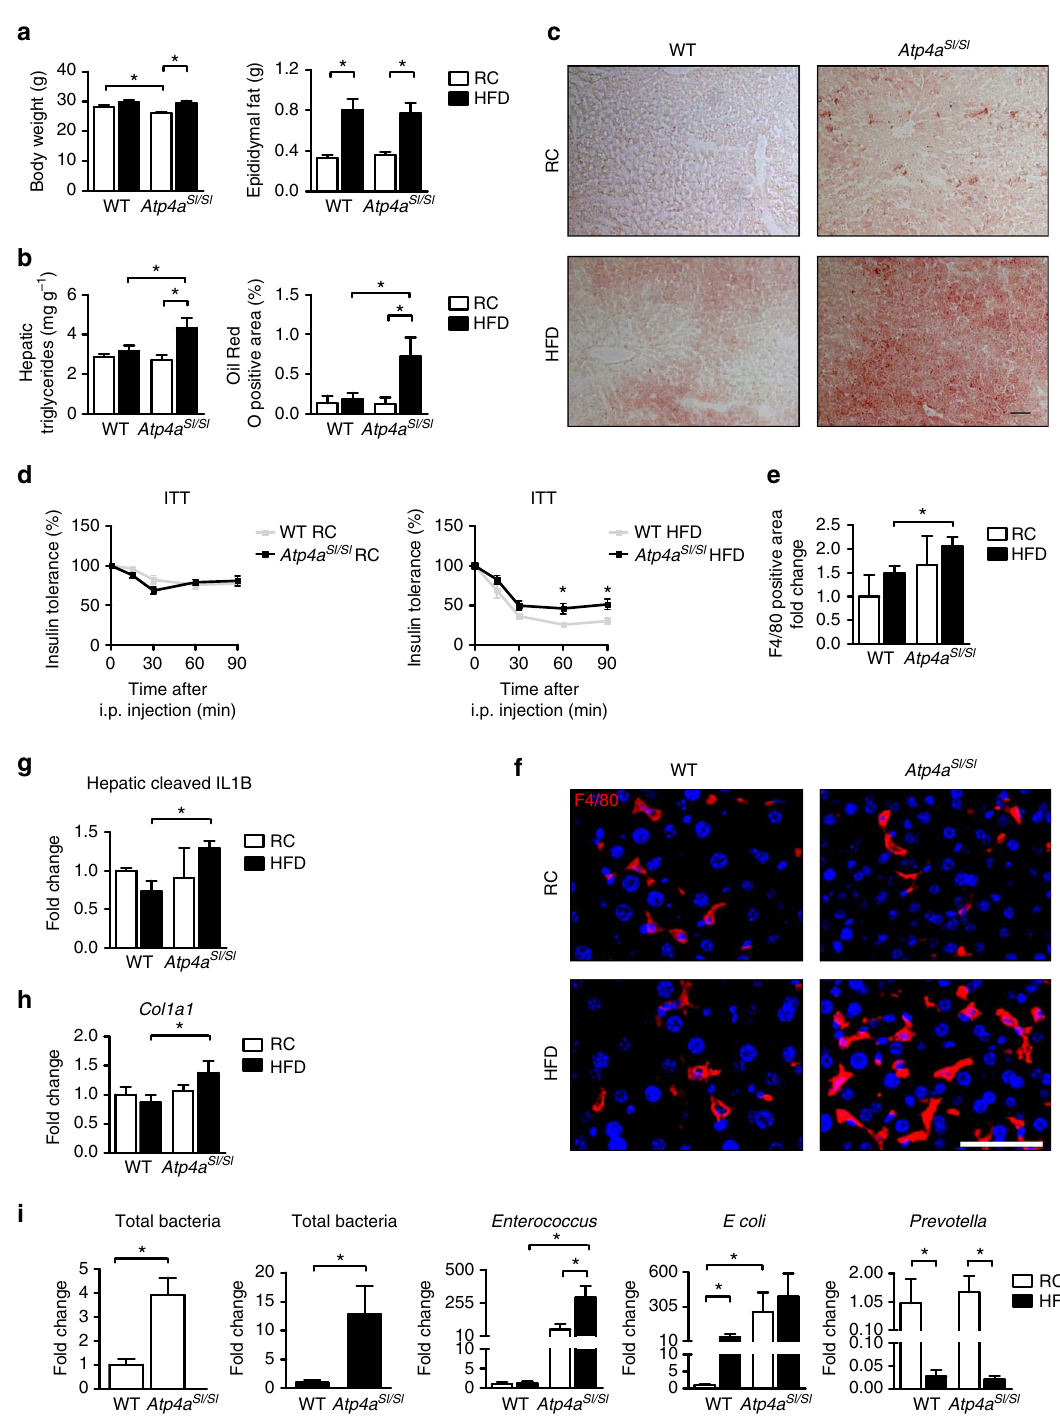
Fig. 2 NAFLD is increased in Atp4a Sl/Sl mice. WT mice and their Atp4a Sl/Sl littermates were fed a regular chow (RC) diet ( n = 5 – 8; 2 – 3 replicates) or a HFD ( n = 6 – 15; 3 – 6 replicates) for 9 weeks. a Body weight and weight of white epididymal fat. b Hepatic triglyceride content and hepatic steatosis visualized with Oil Red O staining and quanti fi ed by image analysis software ( n = 5 – 10). Scale bar = 100 μ m. c Representative Oil Red O-stained liver sections.